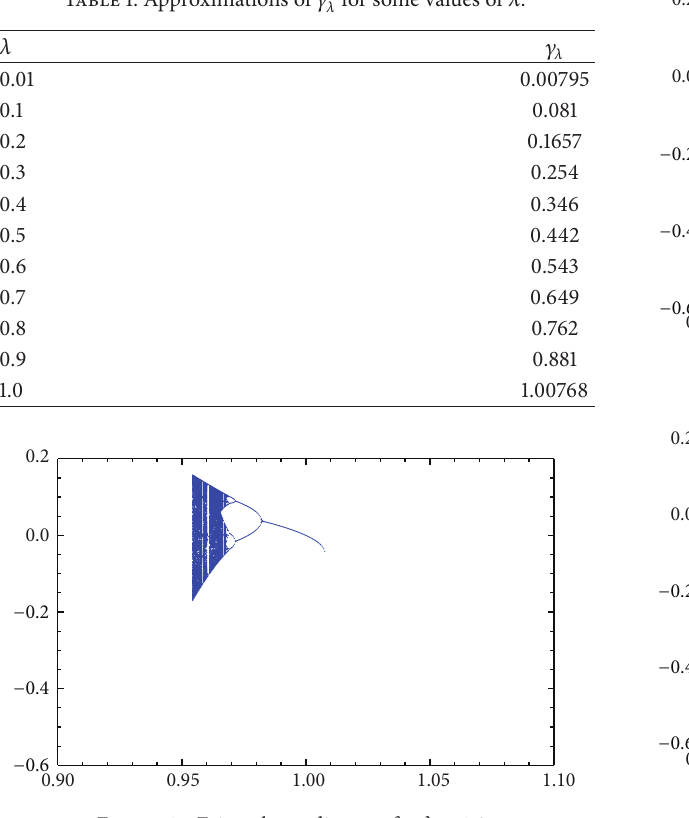
Table 1: Approximations of 𝛾 𝜆 for some values of 𝜆 .